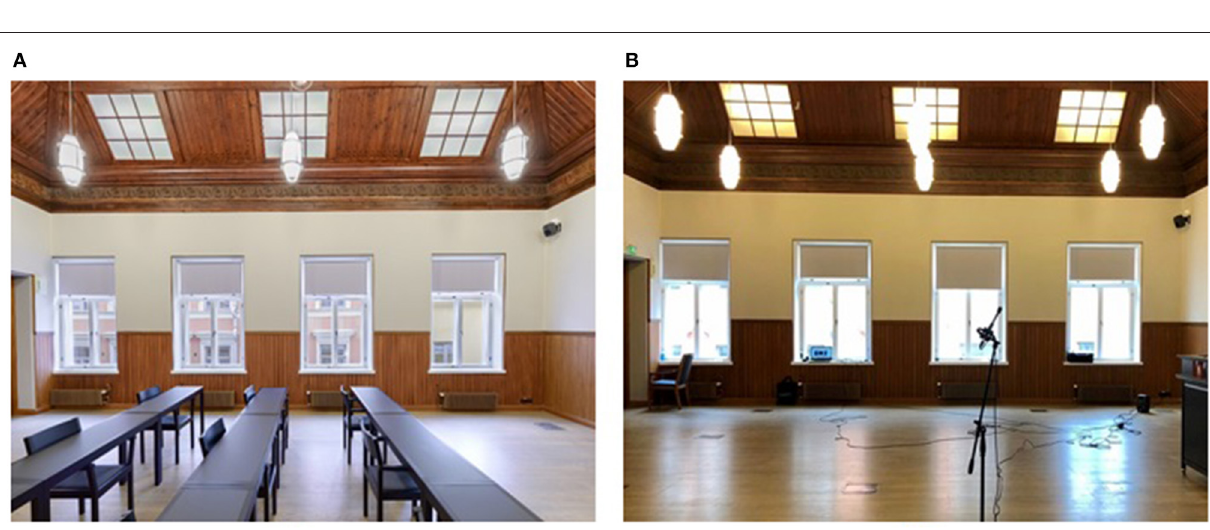
FIGURE 7 | The historical room in the Supreme Court, before (A) and after (B) the acoustic